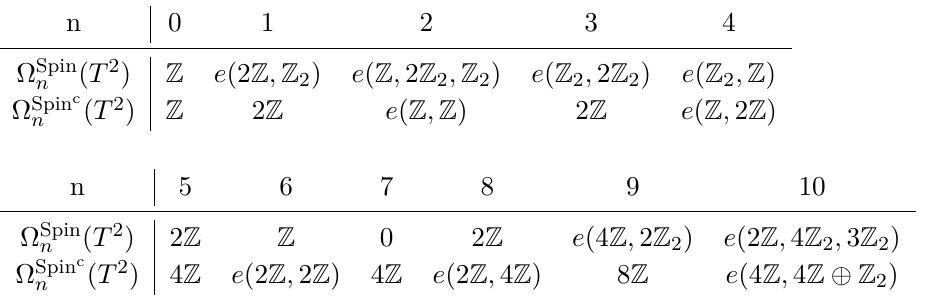
( T 2 ) and Ω Spin c ( T 2 ) , n = 0 , . . . , 10 , up to extensions. n n